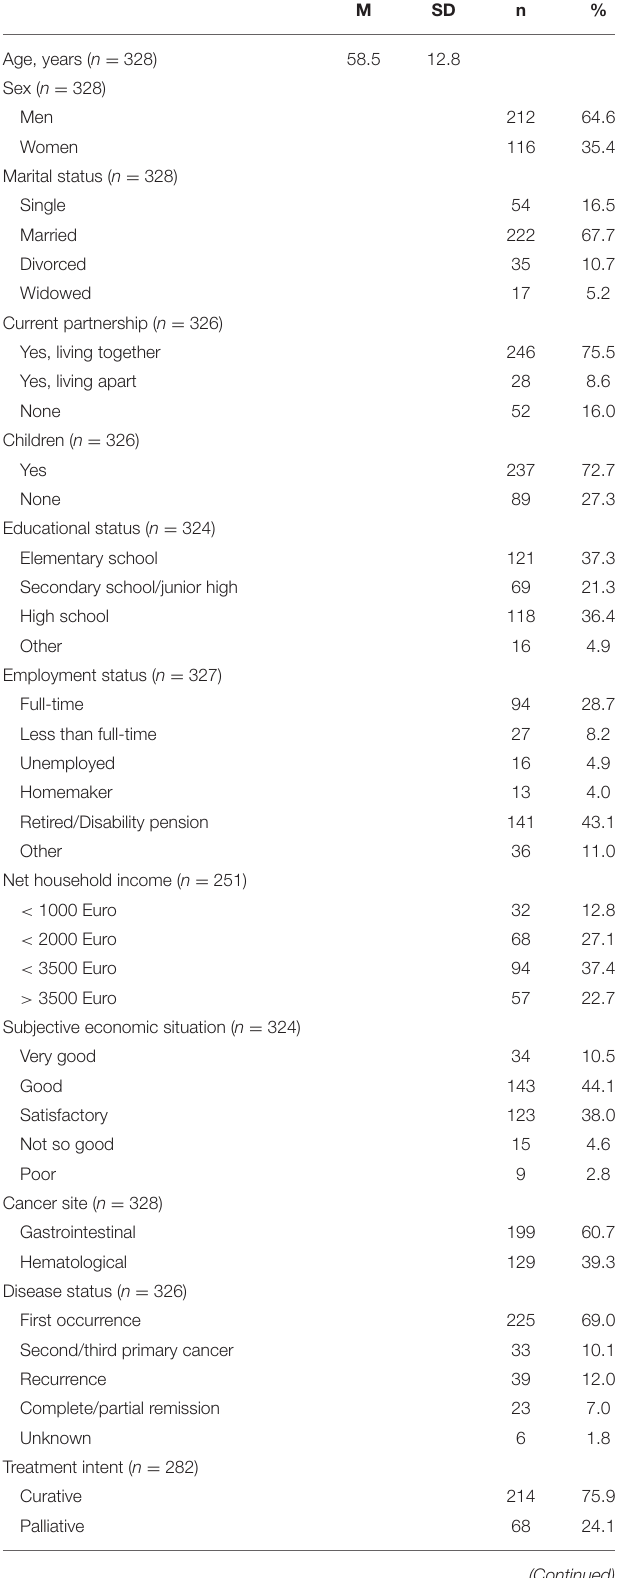
TABLE 1 | Sociodemographic and clinical characteristics ( N =